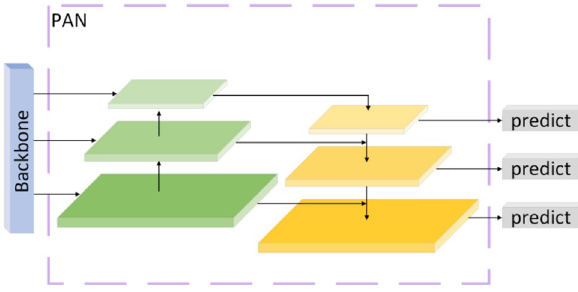
Fig. 11 The structure of YOLOV4 and